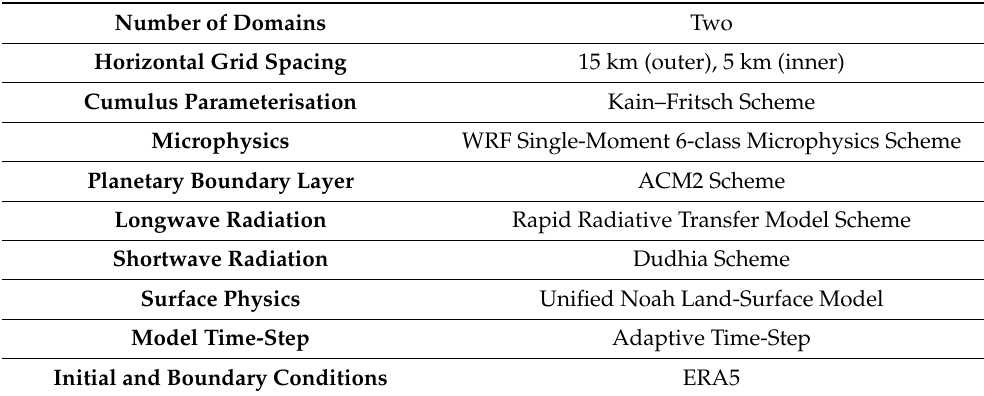
Table 1. Summary of selected WRF configuration schemes.